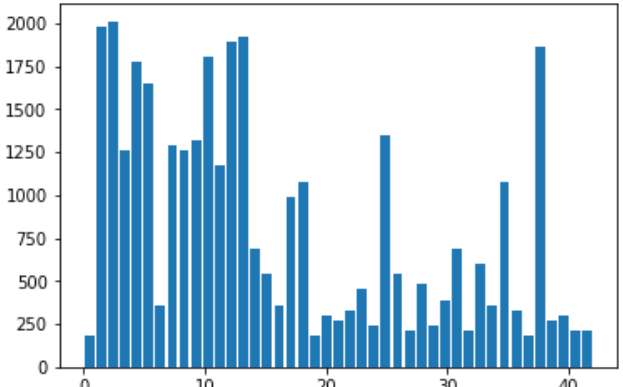
Figure 7. The number of 43 classes of traffic signs.